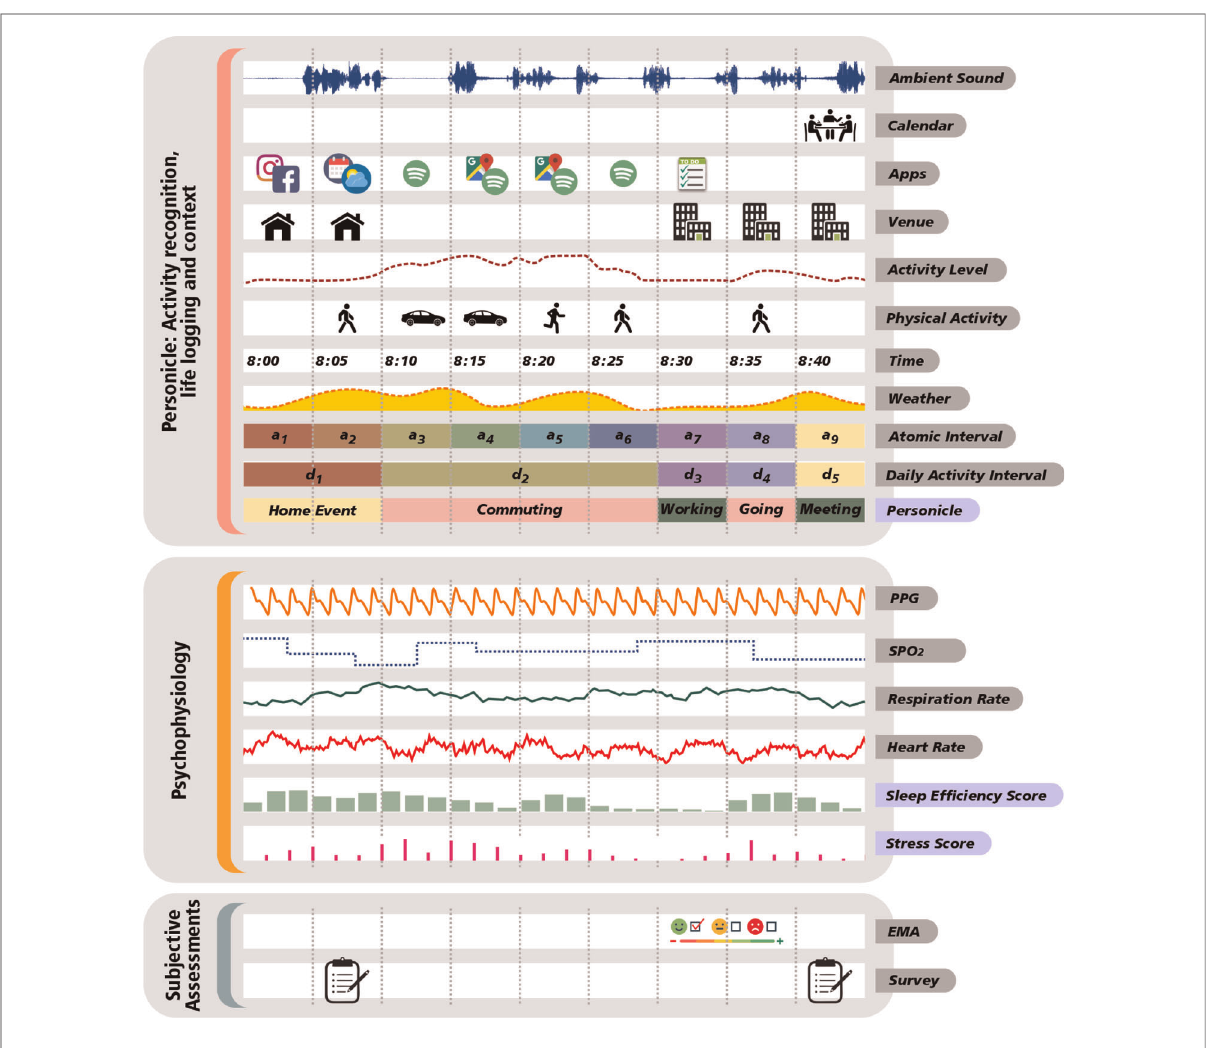
FIGURE 2 Monitor as the main subjective and objective data collection